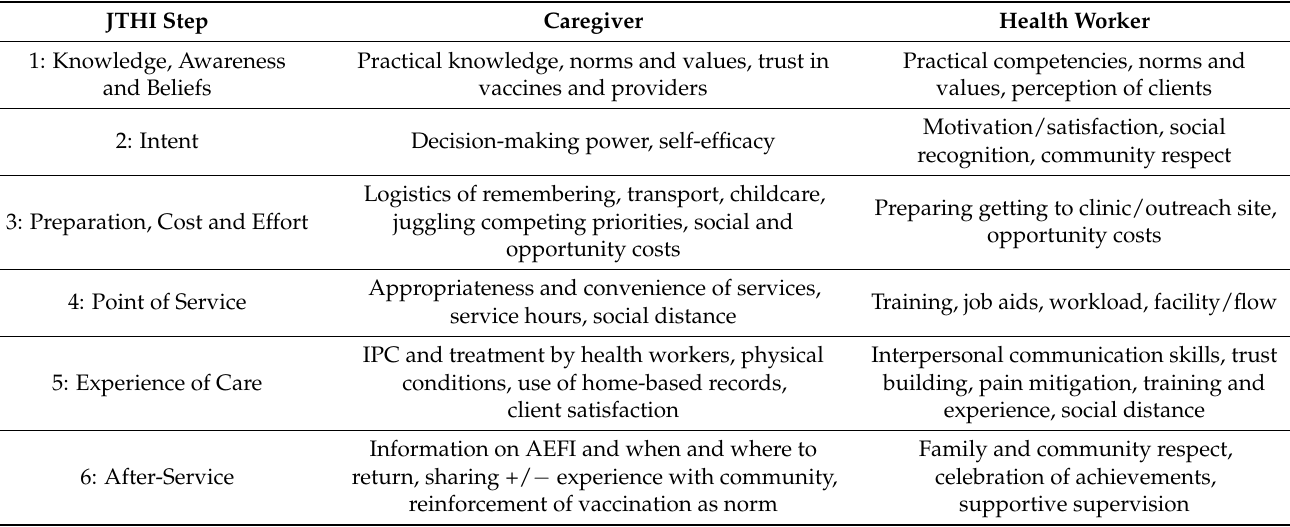
Table 1. Key caregiver and health worker dimensions of the JTHI framework